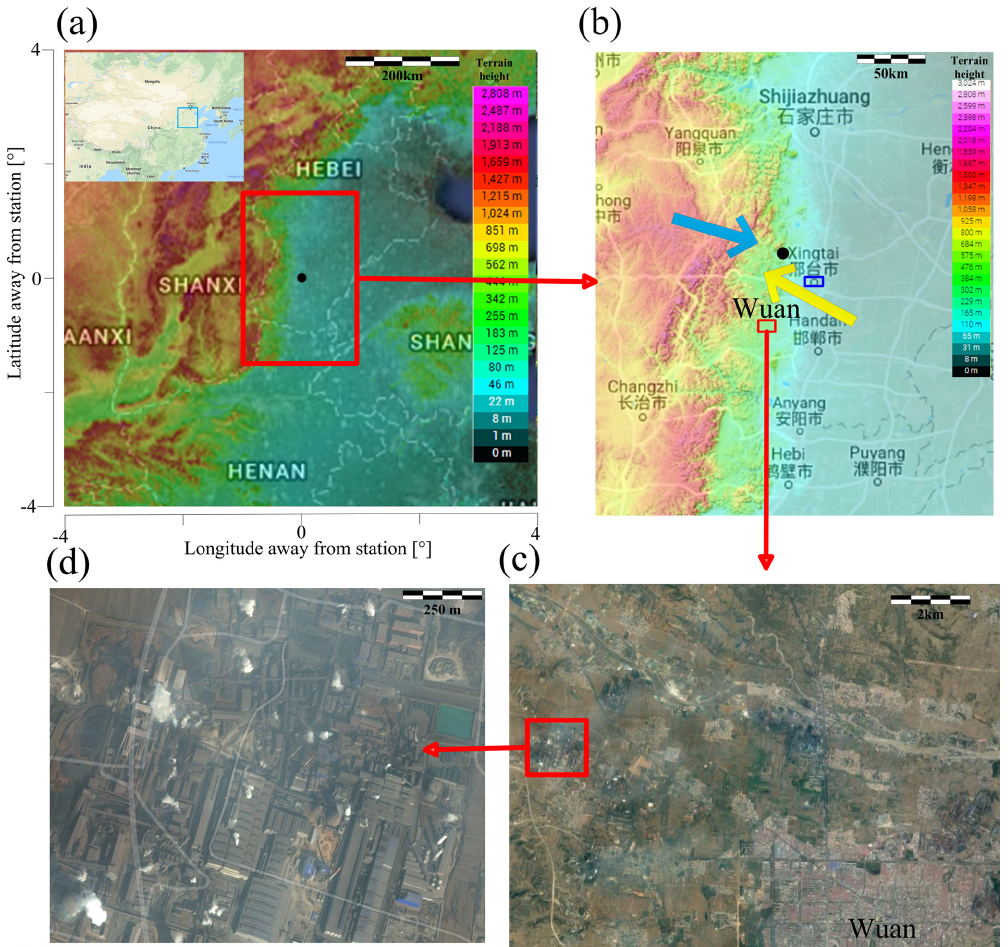
Figure 1. Topography maps (http://en-au.topographic-map.com/places/China-8955742/, last access: 6 April 2019) and satellite images (Google Maps) of the region around the measurement station (37.18 ◦ N, 114.37 ◦ E), marked in panels (a) and (b) by black dots. (a) To- pography map in longitude and latitude ranges of ± 4 ◦ (about ± 360km) around the measurement station; colours indicate the terrain height, and a map indicating the location of the selected region in China is shown in the top-left corner. (b) Topography map of the area marked by the red square in (a) ; the blue and red squares indicate the areas of Xingtai and Wu’an; the blue (NW wind) and red (SE wind) arrows represent the dominant wind directions before and after 10:00BT (GMT + 8), respectively. (c) Satellite image of the area around Wu’an marked by the red square in (b) ; an industrial area (with many stacks of several iron and coal coking facilities) and the downtown area of Wu’an are located in the north-western and south-eastern parts of the image. (d) Zoomed satellite image of one iron and coal coking unit marked by the red square in (c)